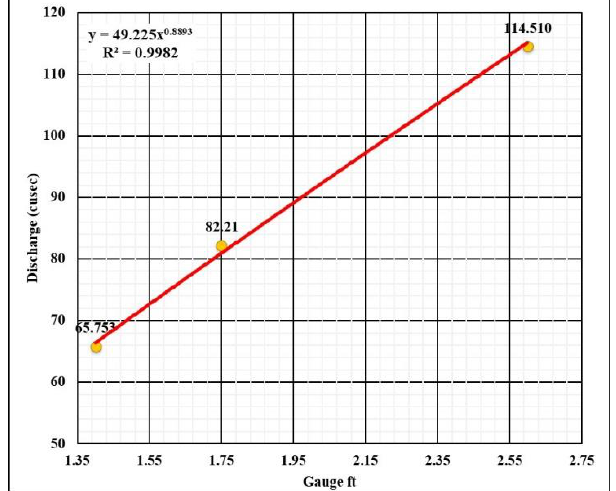
Figure 5: Represents a linear curve for measured discharge at a different gauge height Table 2: Illustrates RT for the different stage-discharge relationship